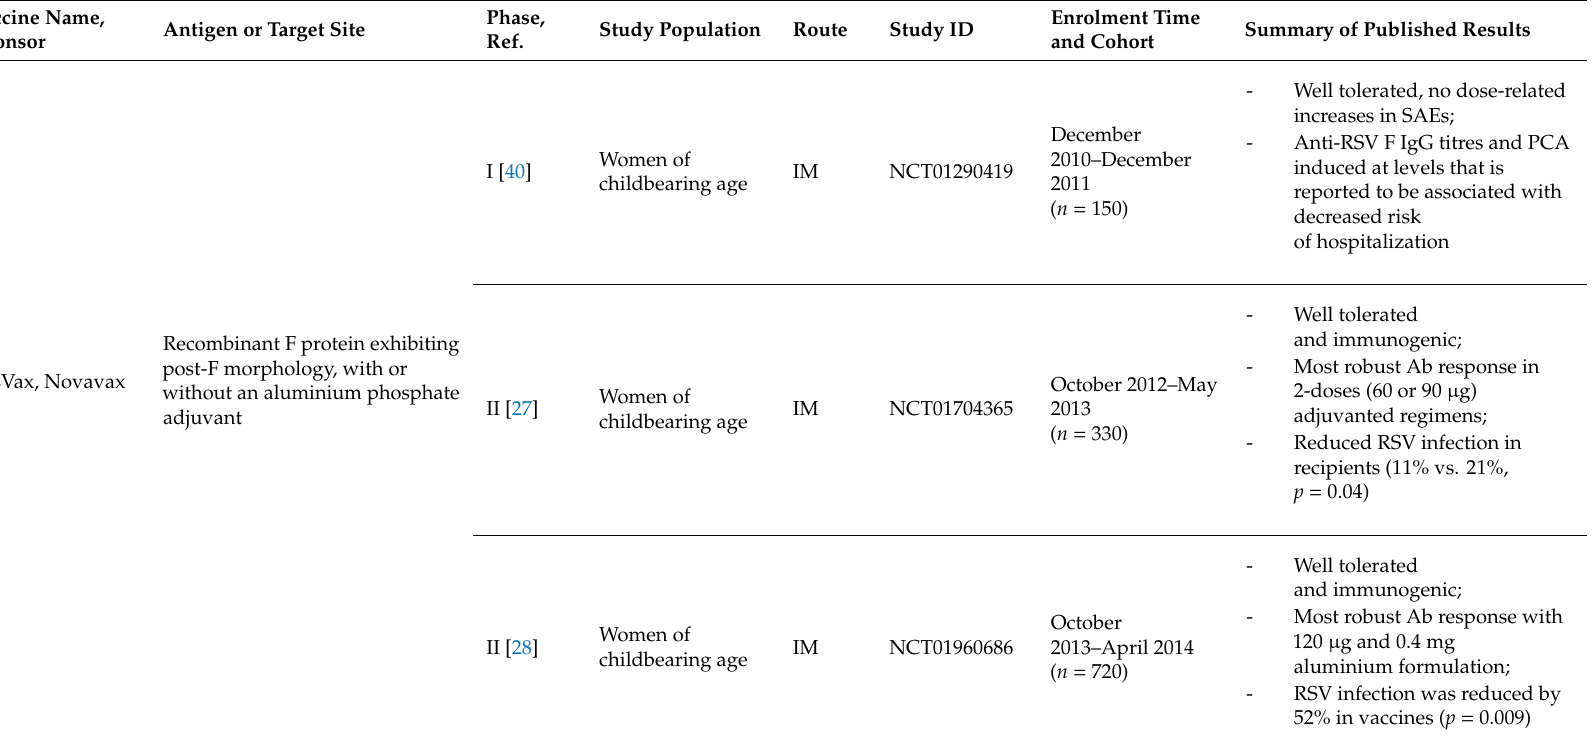
Table 2. Overview of the RSV particle-based vaccines under clinical development. Ab: antibody; ADA: anti-drug antibody; AE: adverse event; Ag: antigen; CI: confidence interval; CHD: congenital heart defect, CLD: chronic lung disease; COPD: chronic obstructive pulmonary disease; Corp: corporation; f.up: follow-up; GA: gestational age; IM: intramuscular; IN: intranasal; IV: intravenous; LRTD: lower respiratory tract disease; LRTI: lower respiratory tract infection; mAb: monoclonal antibody; NA: not available; NIAID: National Institute of Allergy and Infectious Diseases; PCA: palivizumab-competing antibody; PIV3: Parainfluenza Virus type 3; Ref: reference; RSV: respiratory Syncytial Virus; RT-PCR: reverse transcriptase polymerase chain reaction; SAE: serious adverse event; TCID 50 : Tissue Culture Infectious Dose 50%; vs.: